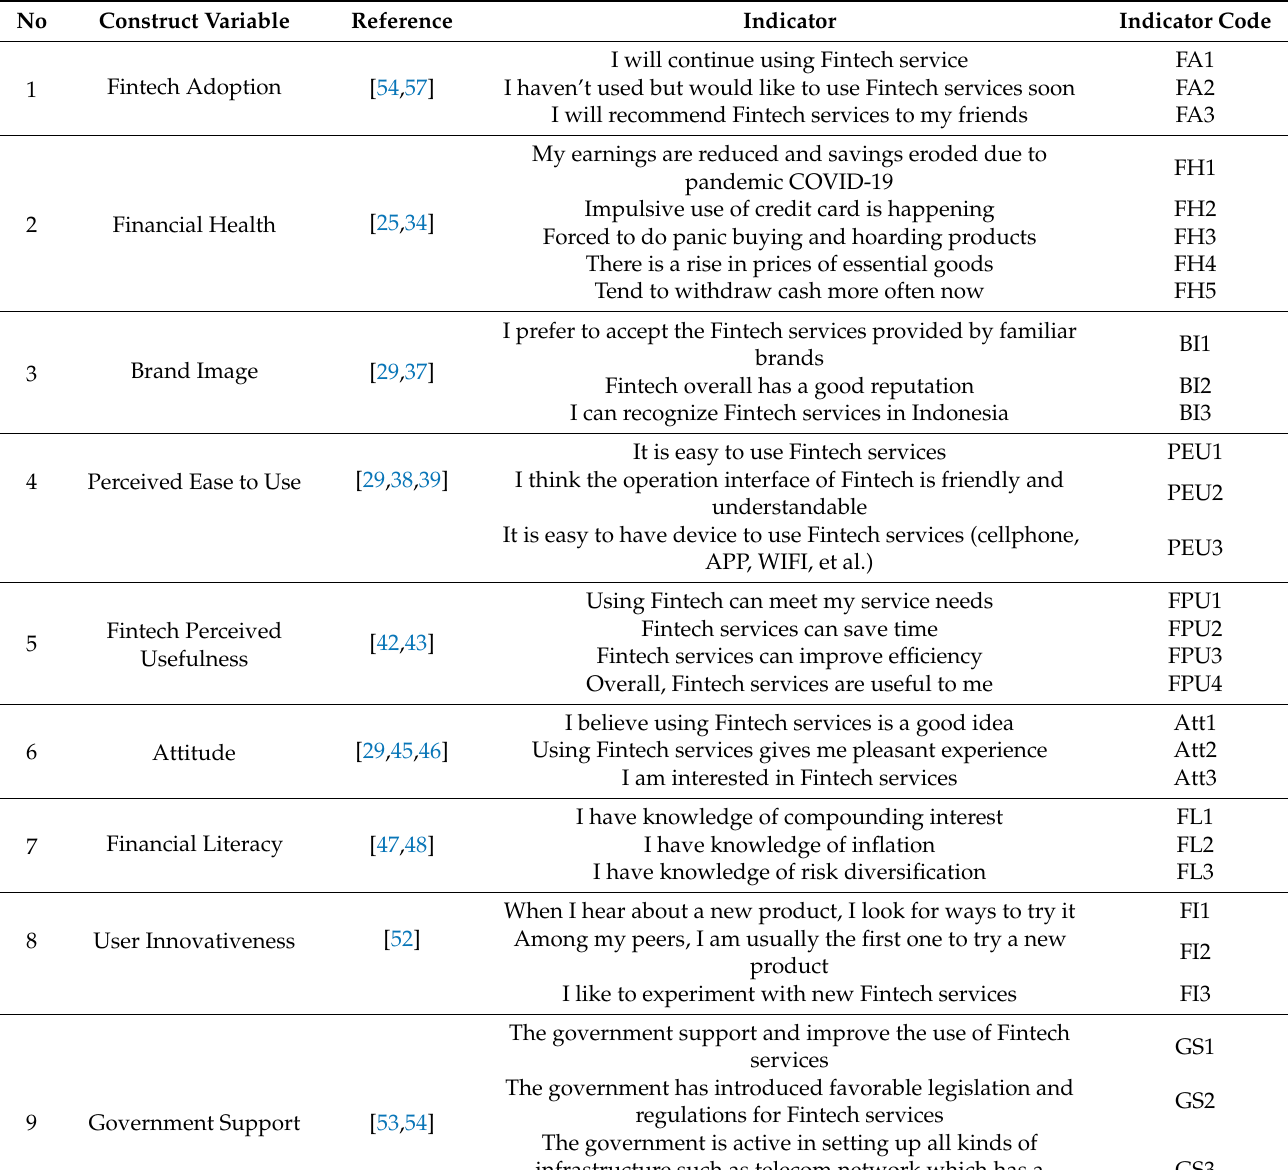
Table 1. Variable